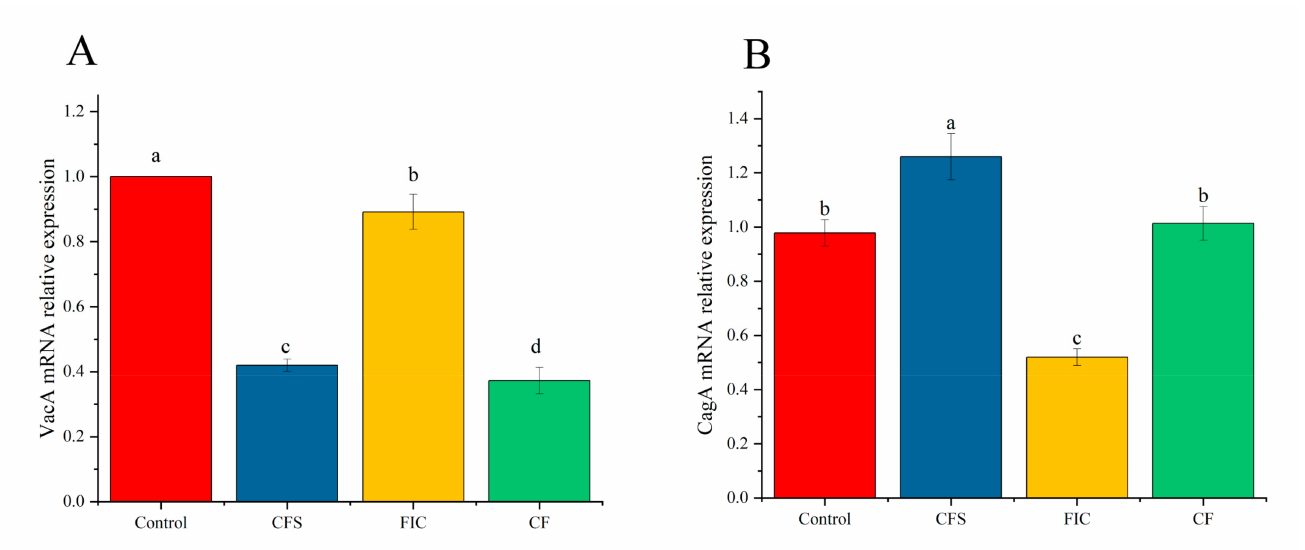
Figure 11. Different treatments on the expression levels of vacA ( A ) and cagA ( B ) genes in the H. pylori 3192 biofilm. CFS: 1/2 × MIC of LN12 CFS treatment, FIC: 1 × FIC of AMX and CLR treatment, CF: 1/2 × MIC of LN12 CFS in combination with 1 × FIC of AMX and CLR treatment. The experimental data are represented by the mean ± standard deviation ( n = 3), and the groups marked with different superscript letters indicate statistically significant differences ( p < 0.05). AMX: Amoxicillin, CLR: